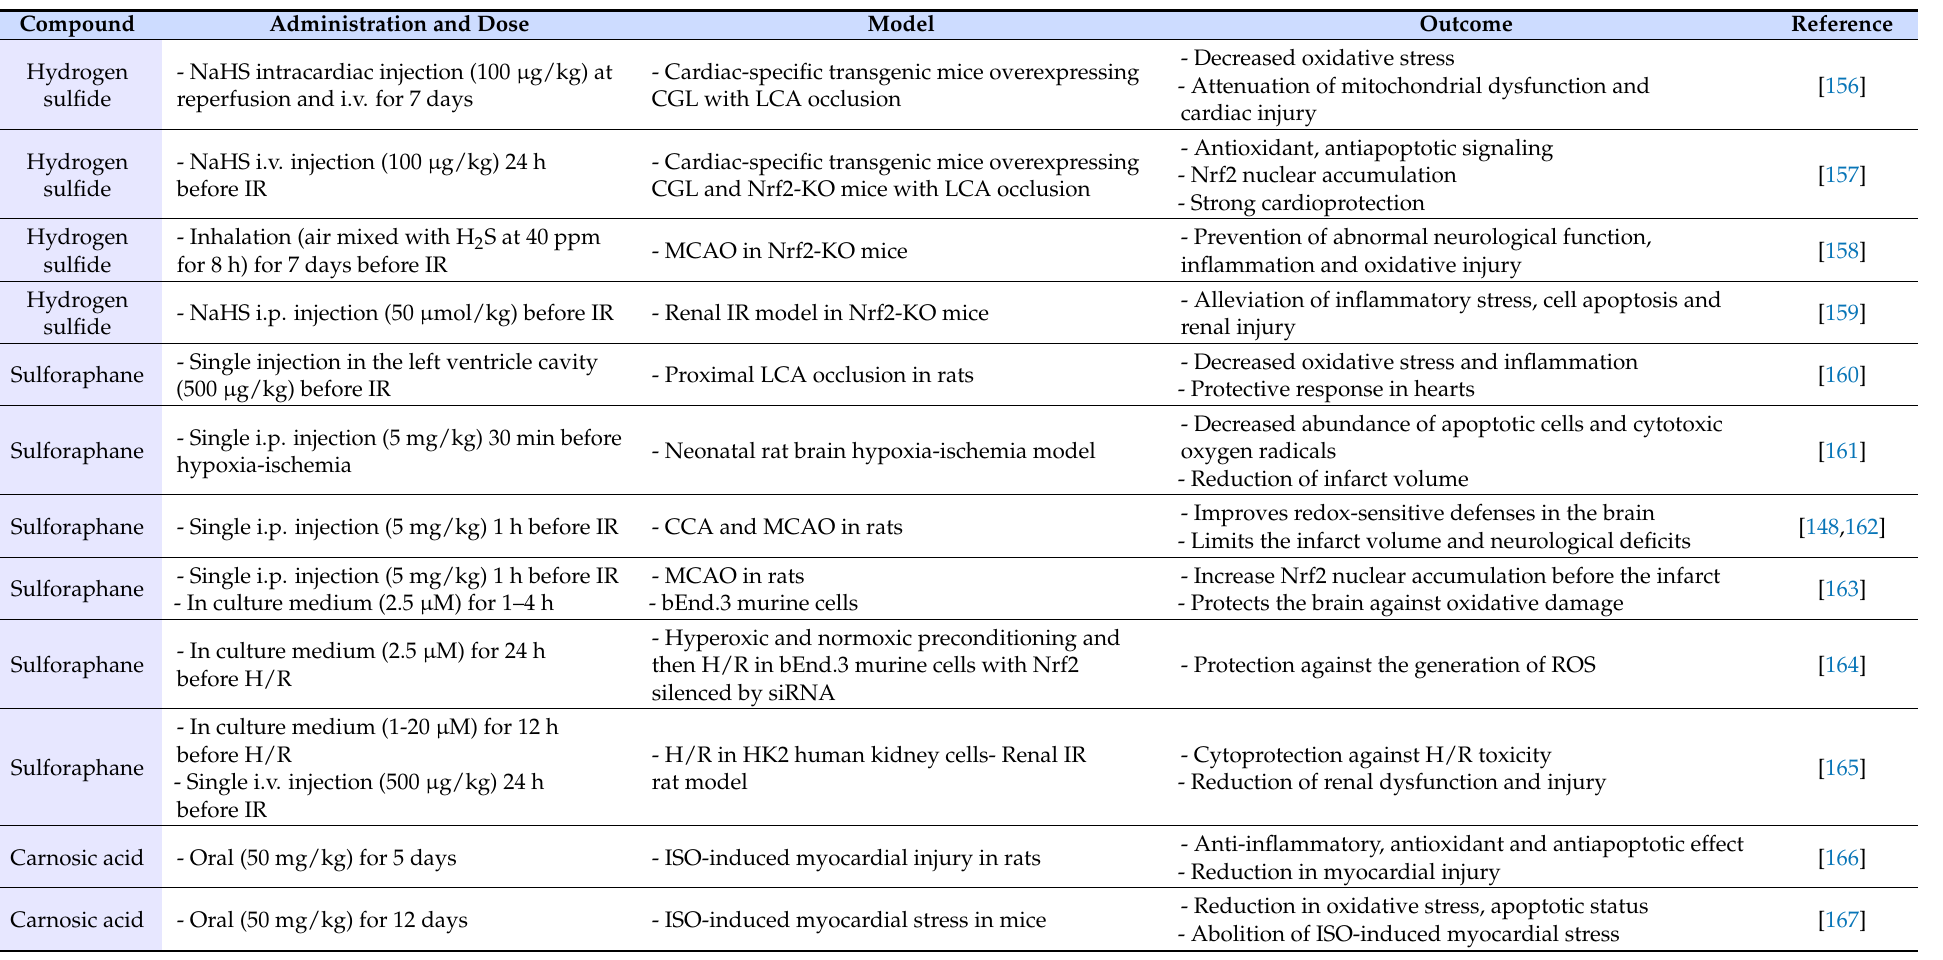
Table 1. Natural and synthetic activators of Nrf2 and their effects on IR injury. The Table shows the compound administered and the models used, and describes the outcomes of the study. ARE, antioxidant response element; CCA, common carotid artery; CGL, cystathionine γ -lyase; Fh1 , fumarate hydratase; H/R, hypoxia/reoxygenation; IR, ischemia–reperfusion; ISO, isoproterenol; LAD, left anterior descending; LCA, left coronary artery; MCAO, middle cerebral artery occlusion; OGD, oxygen and glucose deprivation; ROS, reactive oxygen species.